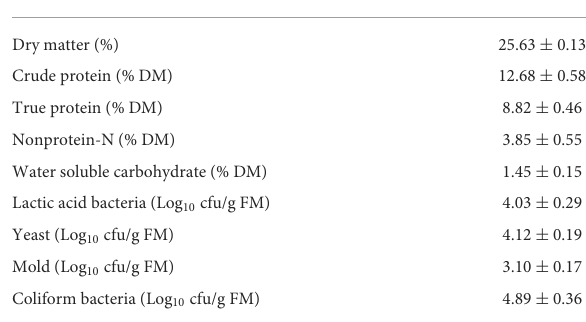
TABLE 1 General characteristics of fresh stylo used for silage